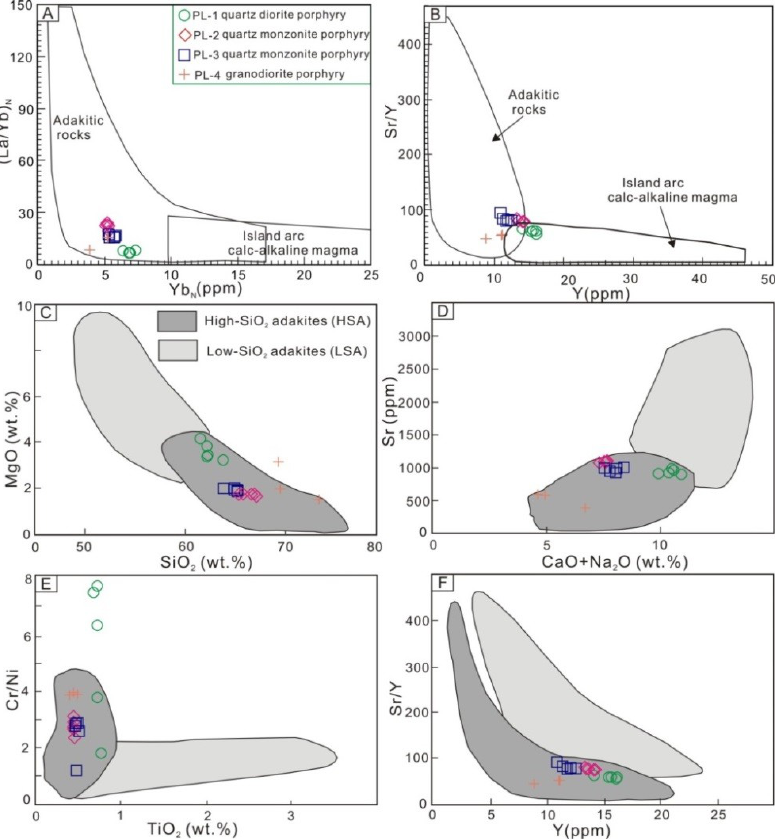
Figure 10. ( A ) (La/Yb) N vs. (Yb) N (based on Martin [79]), ( B ) Sr/Y vs. Y (Defant and Drummond [62]), ( C ) SiO 2 vs. MgO (based on Martin et al. [63]), ( D ) SiO 2 vs. Sr (based on Martin et al. [63]), ( E ) SiO 2 vs. Cr/Ni (based on Martin et al. [63]), and ( F ) SiO 2 vs. Sr/Y (based on Martin et al. [63]) discrimination diagrams for Pulang porphyry intrusions.